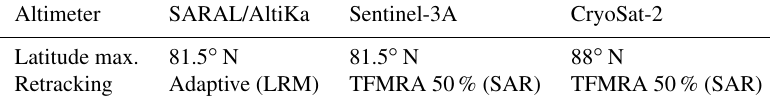
Table 2. Arctic leads’ product characteristics. LRM: low-resolution mode. TFMRA: threshold first-maximum retracker algorithm.